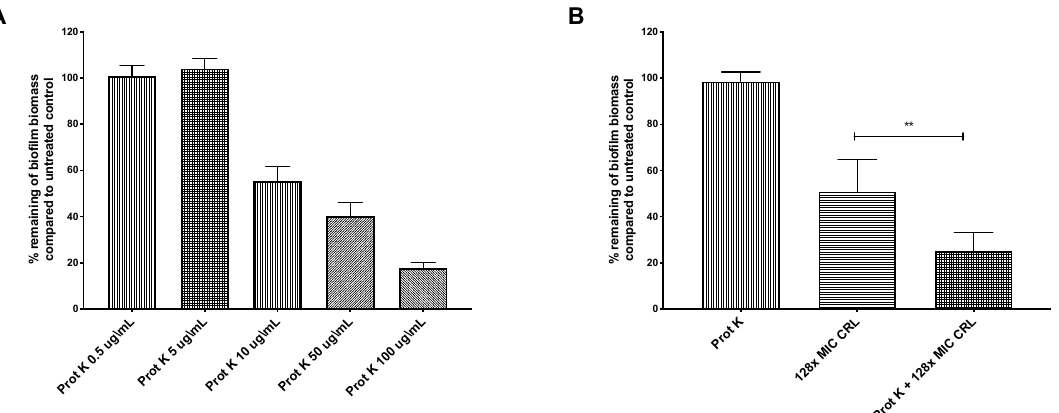
Figure 3. Proteinase K treatment sensitizes H. pylori G27 biofilms to clarithromycin. H. pylori G27 was grown as a biofilm for 48 h (as done in Figure 1) before exposure to varying doses of proteinase K (Prot K) ± clarithromycin (CRL) for 24 h. The biofilm biomass was determined by crystal violet staining, and compared to untreated controls (fresh media without antibiotic and/or proteinase K). (A) Proteinase K (Prot K) dose response. (B) Proteinase K at 5 µg/mL (Prot K), clarithromycin (CRL), or both treatments. Experiments were performed three independent times with at least eight technical replicates for each. Error bars represent standard errors of the mean. Statistical analyses were performed using ANOVA ( ∗∗ , p < 0.01).